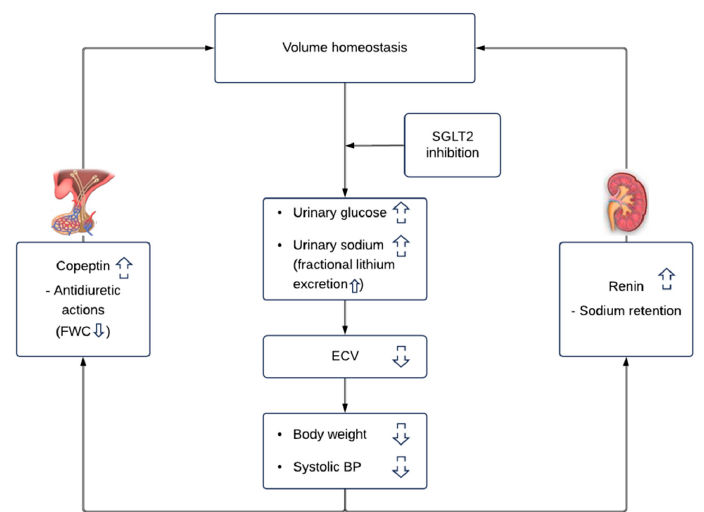
Figure 3: Effects of the sodium glucose co-transporter 2 (SGLT2) inhibitor dapagliflozin on